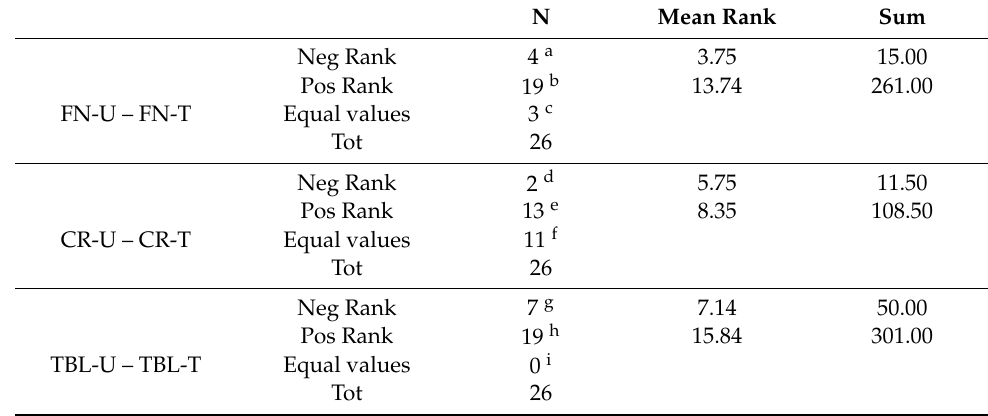
Table 4. Non Parametric Test. Wilcoxon test. Distribution of ranks. a. FN-U < FN-T; b. FN-U > FN-T;